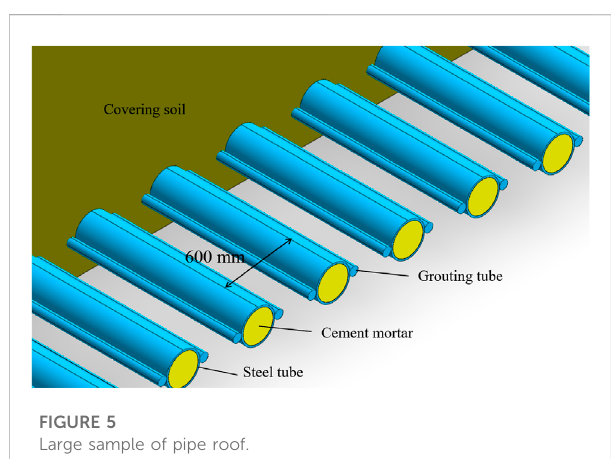
FIGURE 5 Large sample of pipe